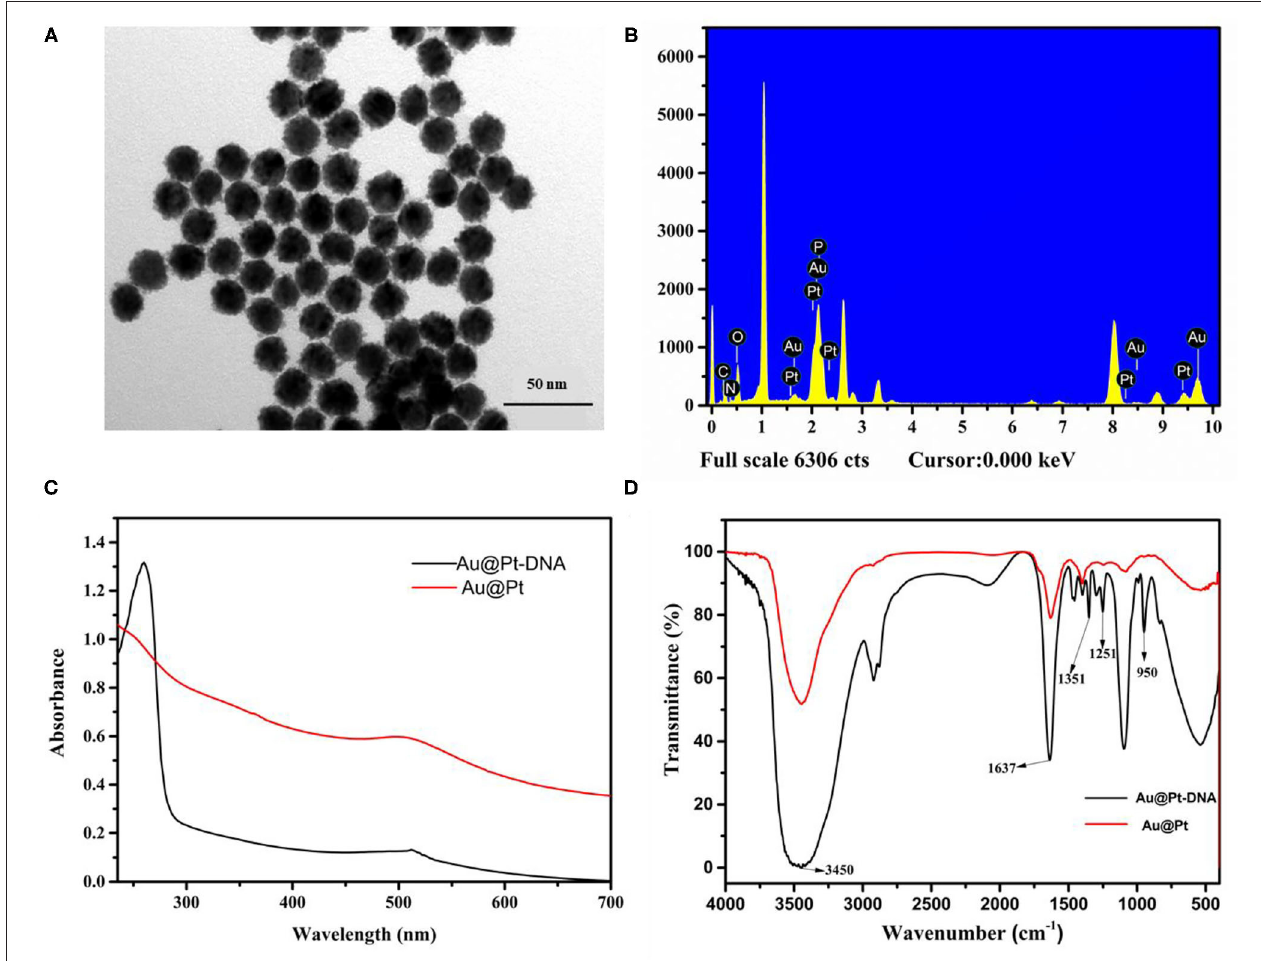
FIGURE 2 | Characterization of Au@Pt and Au@Pt probes. (A) TEM of Au@Pt; (B) EDS of Au@Pt probe; (C) UV-Vis spectra of Au@Pt and Au@Pt probes; and (D) FTIR spectra of Au@Pt and Au@Pt